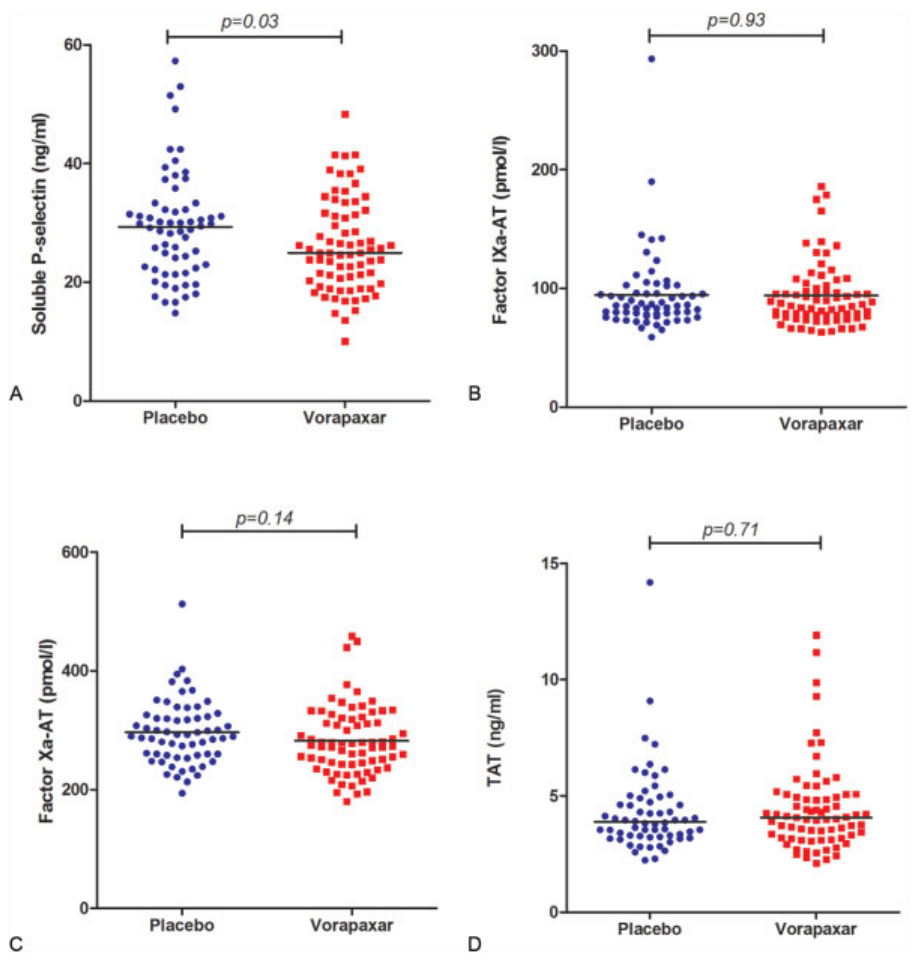
Fig. 1 Results of soluble P-selectin, FIXa-AT, FXa-AT, and TAT complexes in vorapaxar-treated patients and placebo group. Compared with the placebo group, vorapaxar-treated patients had signi fi cantly lower levels of soluble P-selectin ( p ¼ 0.03) ( A ). No signi fi cant differences were found in factor IXa-antithrombin (FIXa-AT) ( B ), factor Xa-antithrombin (FXa-AT) ( C ), and thrombin – antithrombin (TAT) ( D ) complexes between vorapaxar-treated patients and the placebo